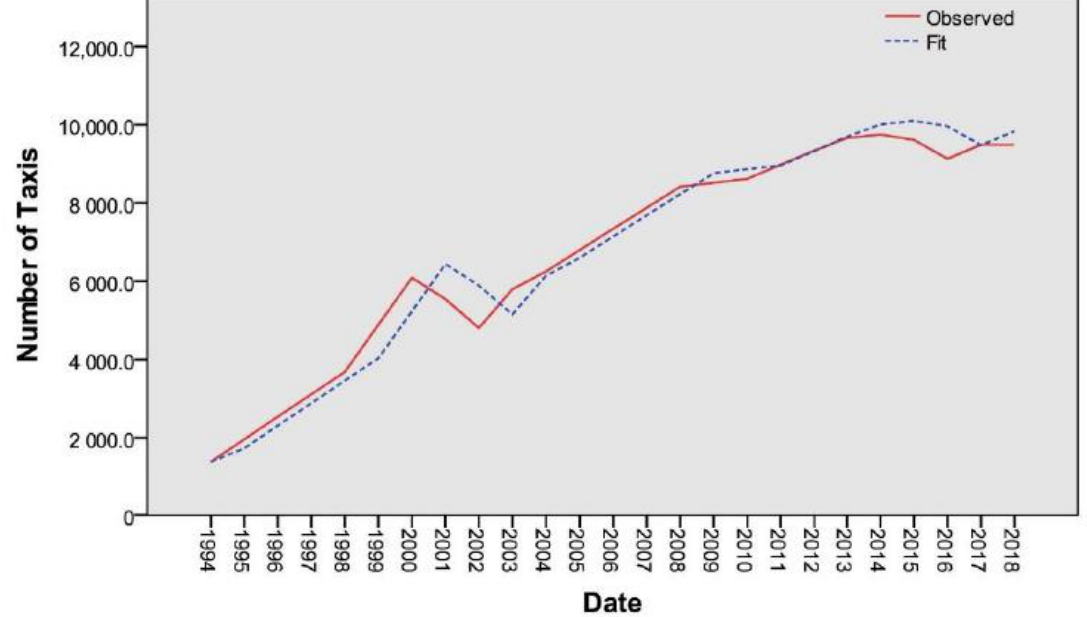
Figure 2. Prediction model for the number of taxis in the West Bank (observed and fit).